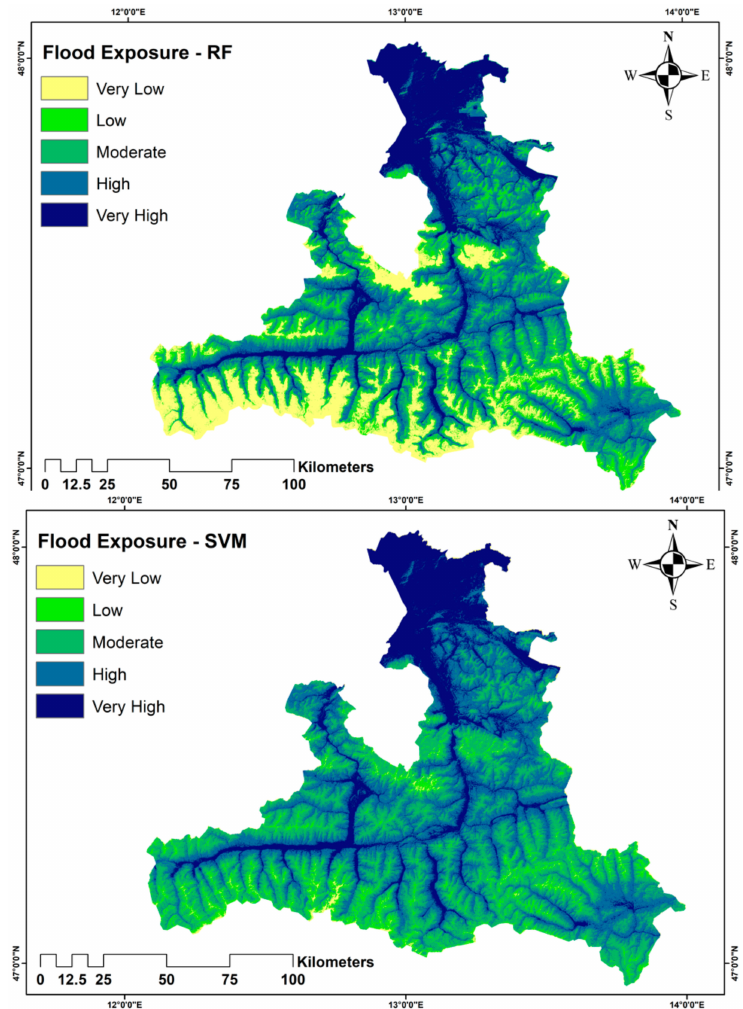
Figure 5. Flood exposure maps derived using random forest (RF) and support vector machine (SVM) for the State of Salzburg. Table 2. Area percentage for each exposure class for flood using RF and SVM for the State of Salzburg. Exposure